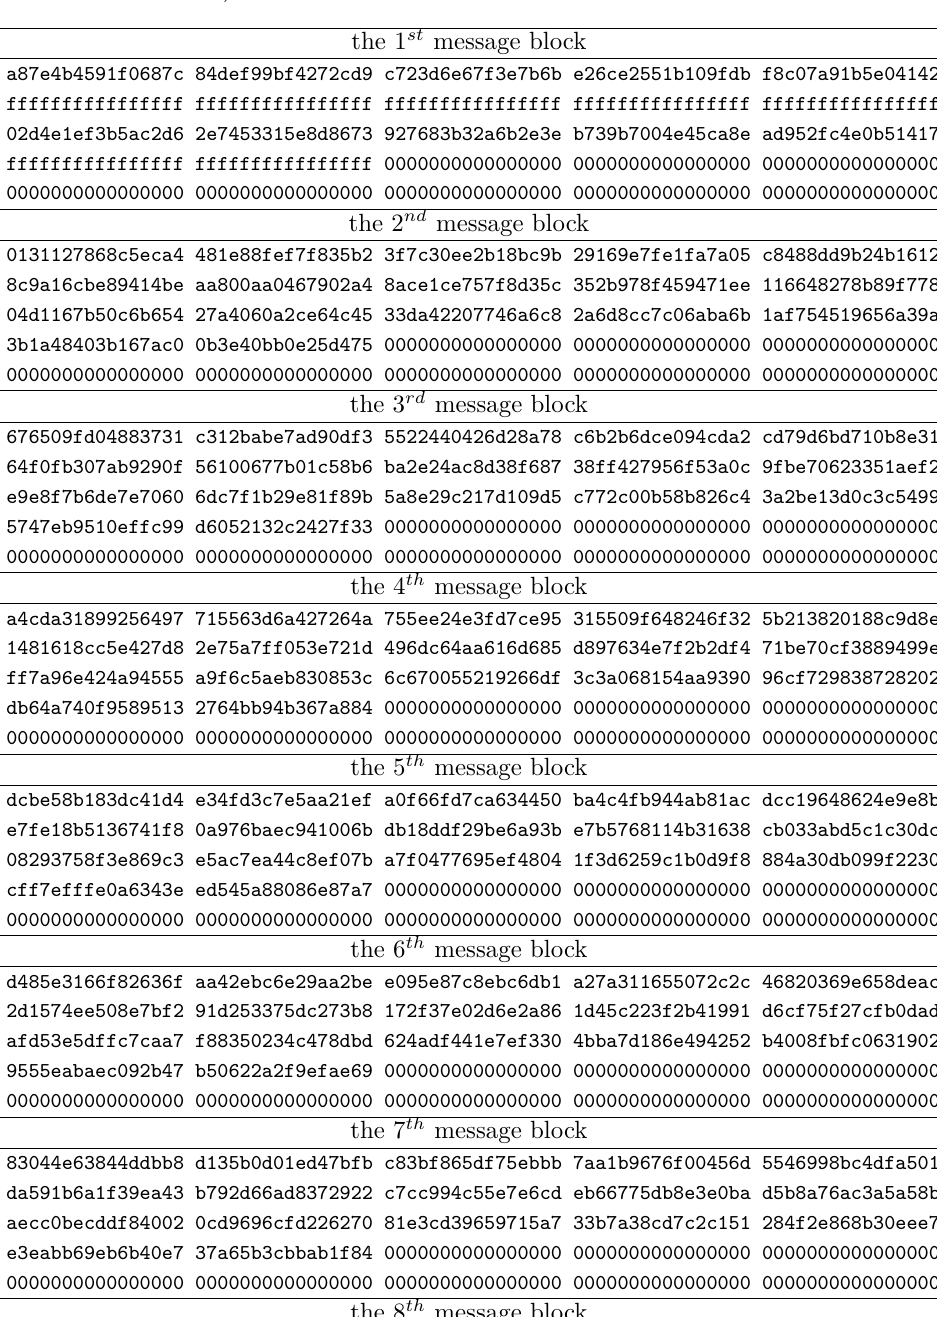
Table 10: The first 12 blocks in the first stage of preimage attacks on 3-round Keccak-256 (in little-endian